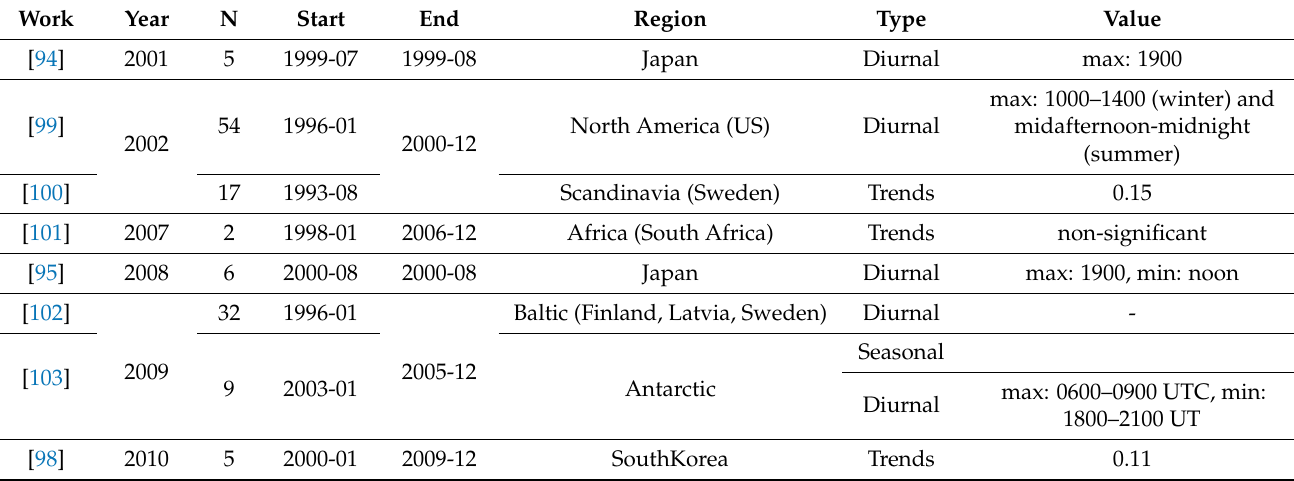
Table 4. Summary of spatio-temporal studies. Unless indicated otherwise, times are given in local solar time and trends in mm year − 1